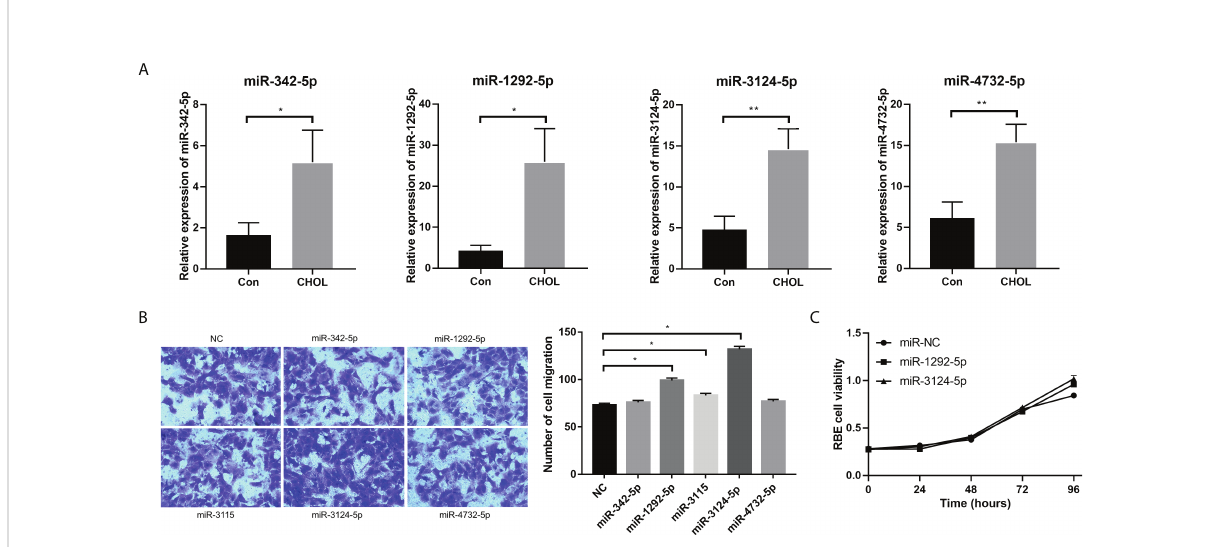
FIGURE 3 The effects of overexpression of exosomal miRNAs (miR-1292-5p, miR-342-5p, miR-4732-5p, miR-3124-5p, and miR-3115) on the migration and proliferation of RBE cells. (A) qPCR showed the expression of miR-342-5p, miR-1292-5p, miR-3124-5p, and miR-4732-5p in serum exosomes from healthy individuals and patients with CHOL. (B) Transwell assay showed the effect of overexpression of exosomal miRNAs on RBE cell migration. (C) CCK-8 assay showed the effect of overexpression of exosomal miRNAs on RBE cell viability. Compared to NC, * p < 0.05 and ** p <